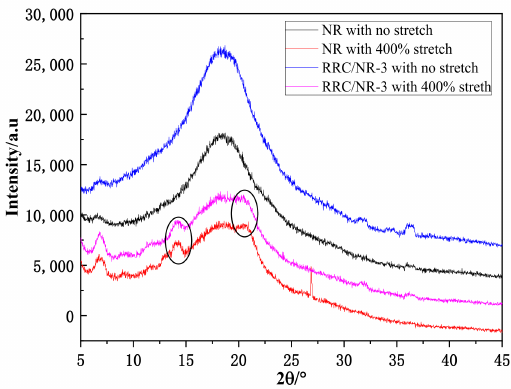
Figure 5. XRD patterns of the NR and RRC/NR samples. The black circle only guide your eyeline.